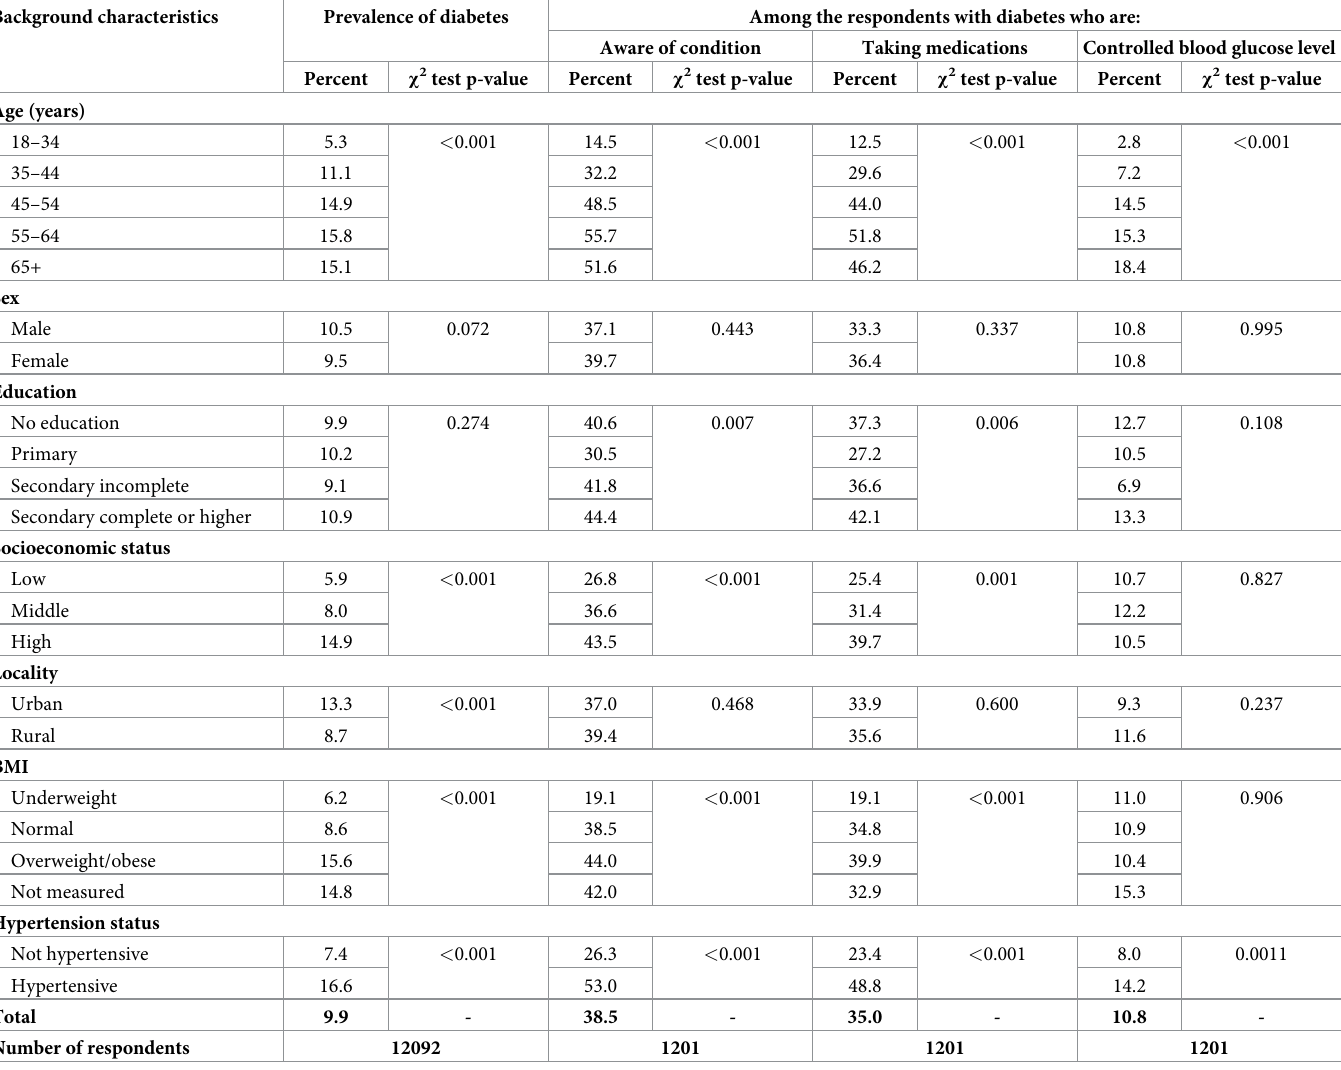
Table 2. Prevalence, awareness, and management of diabetes among the adult population by background characteristics, Bangladesh 2017–18. Background